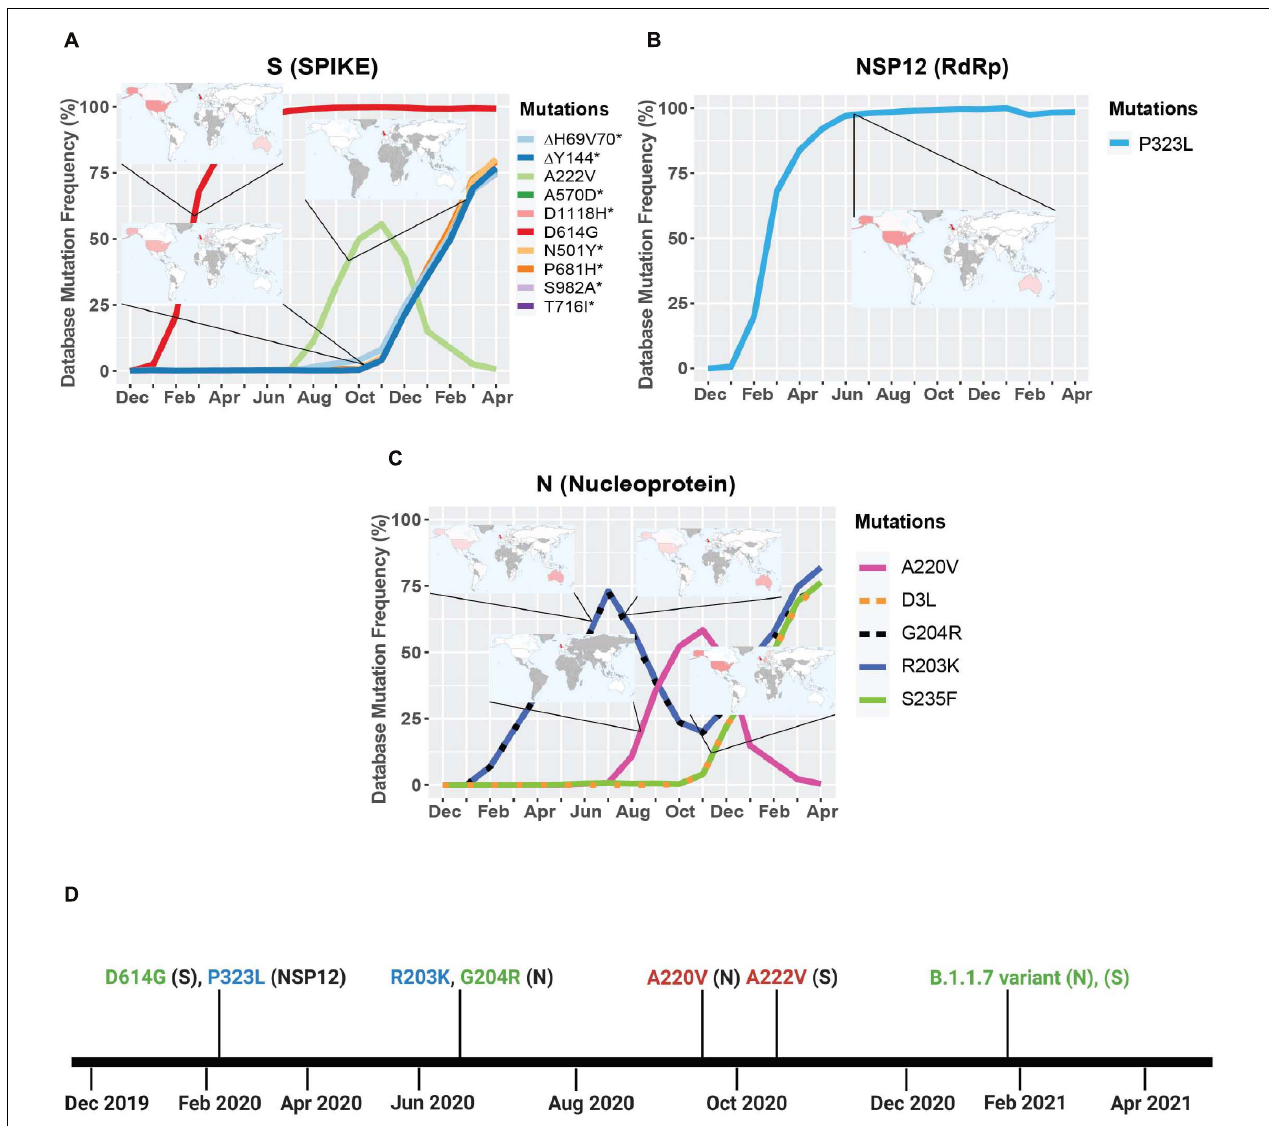
FIGURE 2 | Geographic location and timeline of dominant mutations in NSP12, S, and N genes. (A) Frequency of S protein mutations with corresponding geographic maps. (B) Frequency of RdRp mutations with corresponding geographic maps. (C) Frequency of nucleoprotein mutations with corresponding geographic maps. (D) Timeline of the appearance of mutations reaching a frequency higher than 50% worldwide between December 2019 and April 2021. For the geomaps: a low frequency of reported cases of the mutations is represented in white, while higher frequencies are represented from pink to red, and gray represents no data. All maps were taken from Global Initiative on Sharing Avian Influenza Data (GISAID). Graphs were generated using RStudio and Biorender. *Overlapping curves.